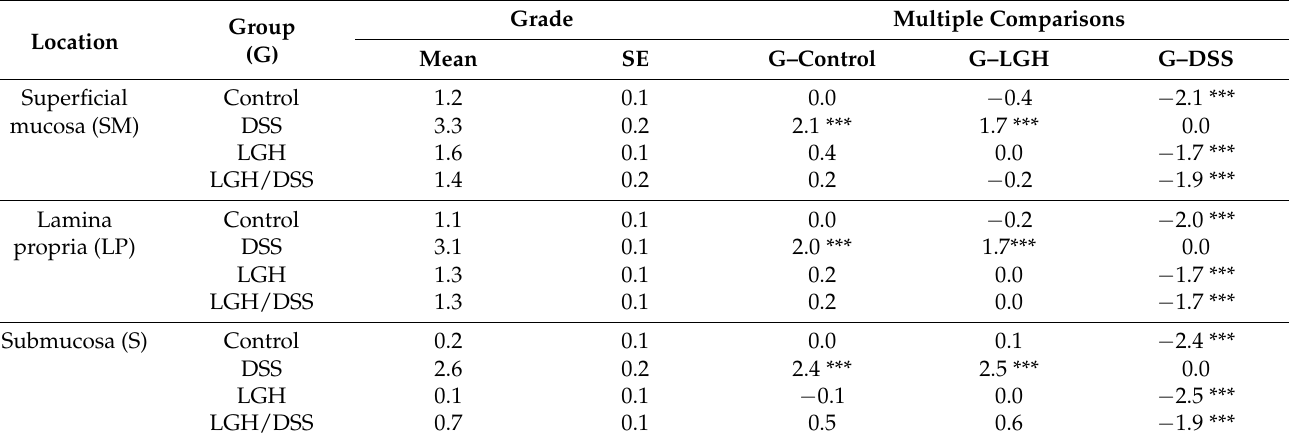
Table 4. Multiple comparisons for TNF- α expression in colonic mucosa and